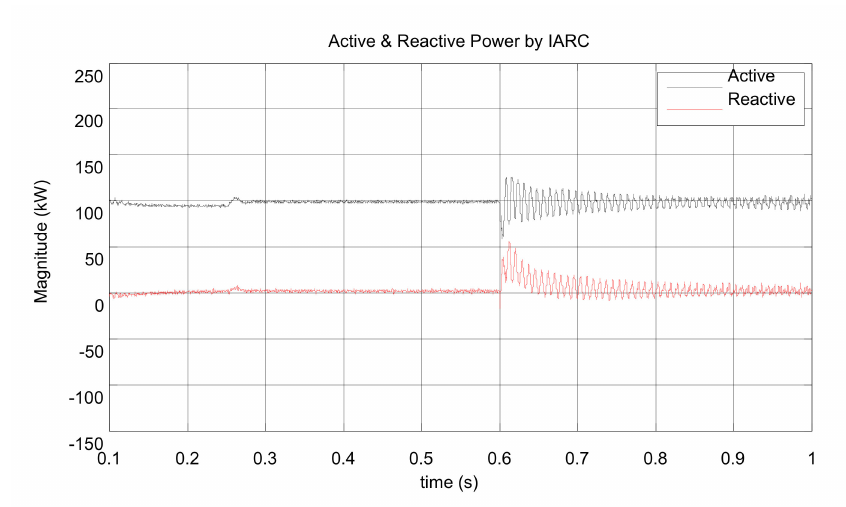
Figure 26. Injected instantaneous power into the grid under ‘type C’ voltage sag.